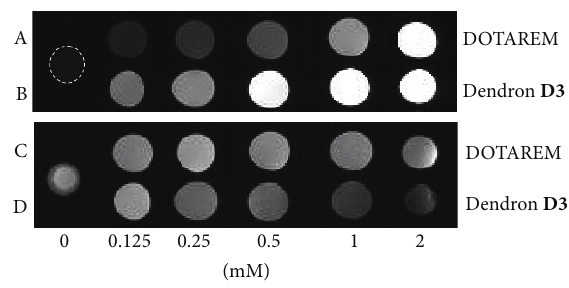
Figure 3: MRI acquisitions at 7.0𝑇 of the phantom samples used for relaxivity calculation. Rows A and C show DOTAREM solutions ( 𝑇 1 and 𝑇 2 weighted MRI acquisitions, resp.) at increasing Gd 3+ concentration listed below the figure, while rows B and D show D3 solutions at the same concentrations/conditions as for DOTAREM, except by 0mM (pure water). There was only one 0 mM (no CA) phantom tube. The faint image corresponding to 0mM is outlined with a dotted white line in the 𝑇 1 weighted acquisitions for better